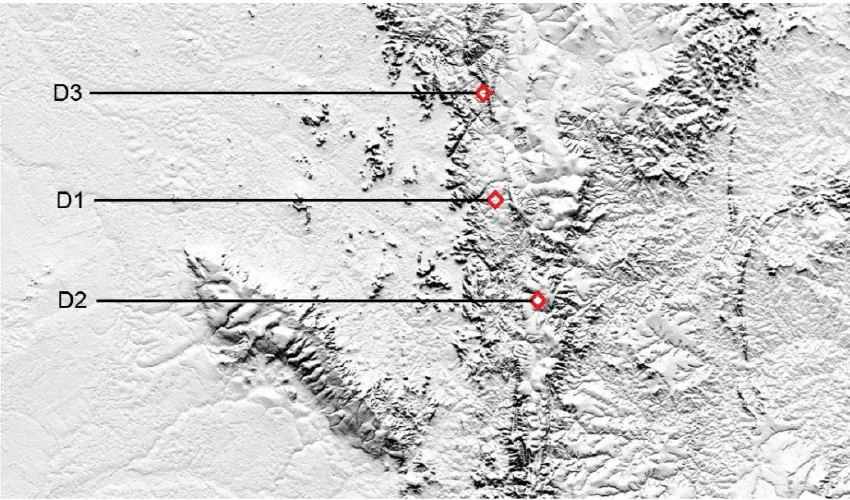
Figure 1. Orographic details of the databases’ specific locations, D1, D2 and